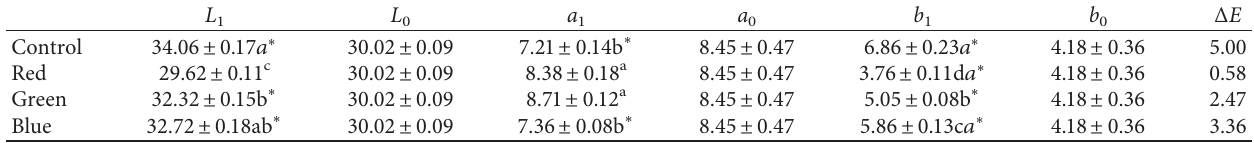
Table 1: Effect of light exposures on color of the fresh-cut watermelon.